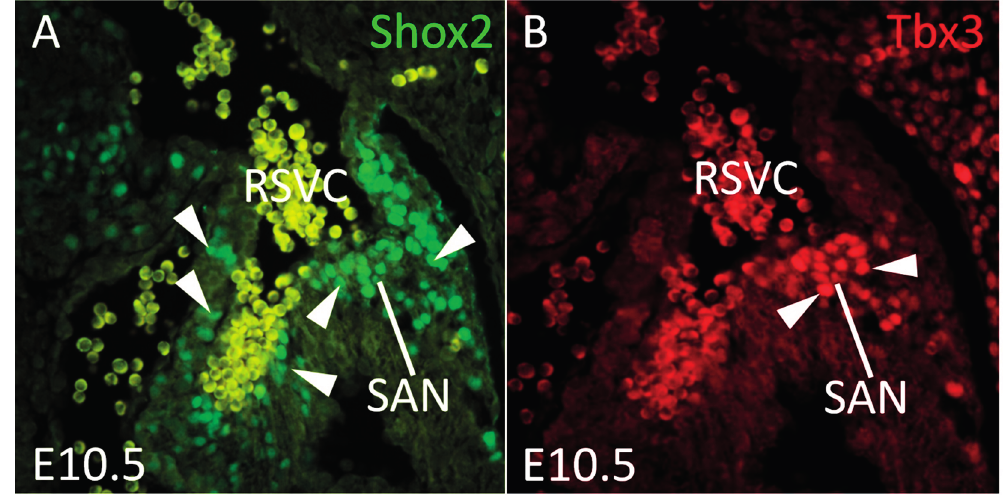
Figure 3. Expression of Shox2 and Tbx3 in the SAN at E10.5. Immunofluorescence